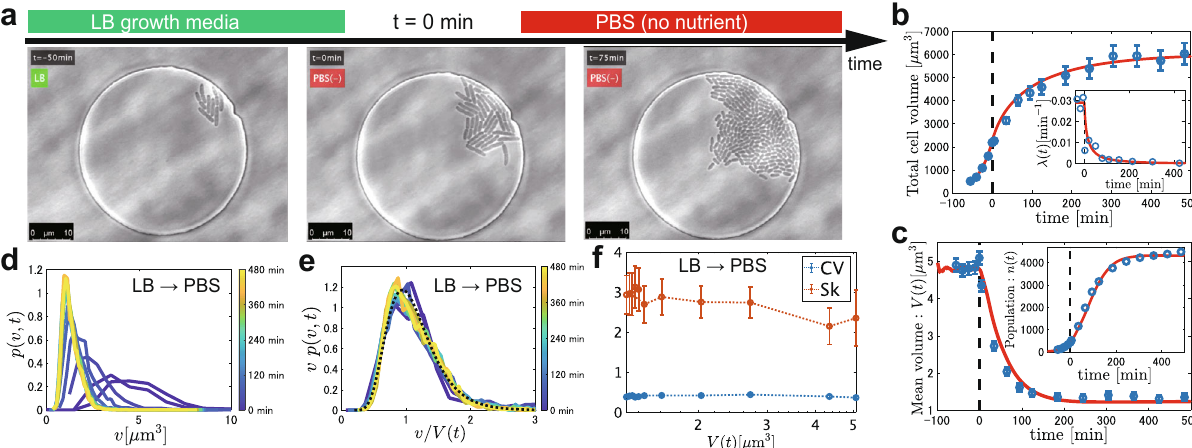
Fig. 2 Results from the observations of reductive division. a Snapshots taken during the reductive division process of E. coli MG1655 in the EMPS. The medium is switched from LB broth to phosphate-buffered saline (PBS) at t = 0. See also Supplementary Movie 7. b , c Experimental data (blue symbols) for the total cell volume V tot ( t ) ( b ), the growth rate λ ( t ) ( b inset, see also Supplementary Fig. 9a showing the same data in logarithmic scale), the mean cell volume V ( t ) ( c ), and the number of the cells n ( t ) ( c inset) in the case of LB → PBS, compared with the simulation results (red curves). The error bars indicate segmentation uncertainty in the image analysis (see “ Methods ” ). t = 0 is the time at which PBS enters the device (black dashed line). The data were collected from 15 wells recorded in a single experiment. d Time evolution of the cell size distributions during starvation in the case of LB → PBS at t ¼ 0 ; 5 ; 30 ; 60 ; 90 ; 120 ; 180 ; 240 ; 300 ; 360 ; 420 ; 480 min from right to left. The sample size is n ( t ) for each distribution (see ( c ) inset). e Rescaling of the data in ( d ). The overlapped curves indicate the function F ( v / V ( t )) in Eq. (2). The dashed line represents the fi tted log-normal distribution ( σ = 0.34(2)). f The coef fi cient of variation (CV) and the skewness (Sk) (Eq. (3)) against V ( t ) = 〈 v 〉 . The error bars were estimated by the bootstrap method with 1000